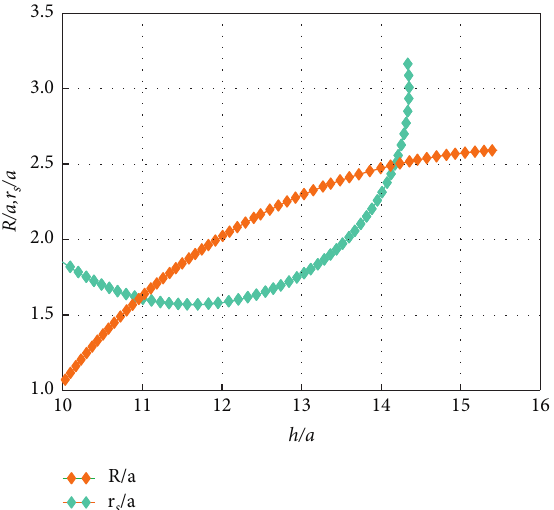
Figure 8: Relationship among h / a , R / a , and r